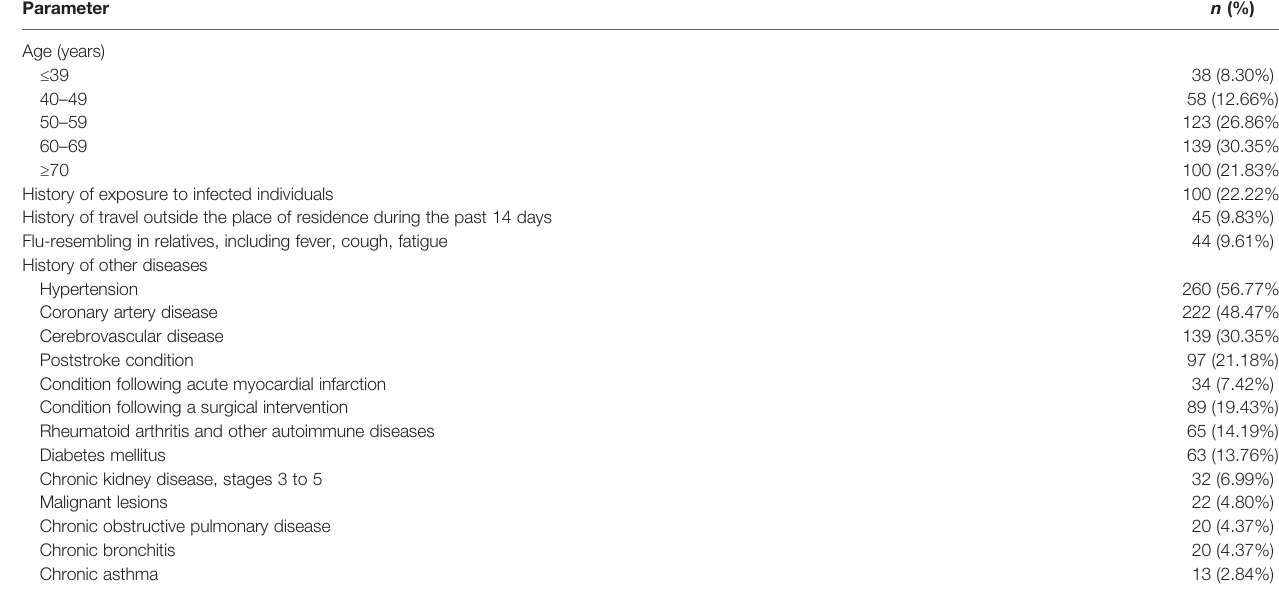
TABLE 1 | Demographic characteristics, history, and comorbidities of the patient study cohort.